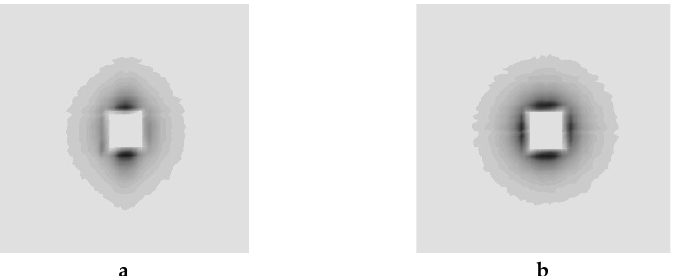
Figure 20. Small angle neutron scattering records (halo) of 1 pass AZ31 at RT for ( a )—39 and ( b )—8 m as distances sample to detector.